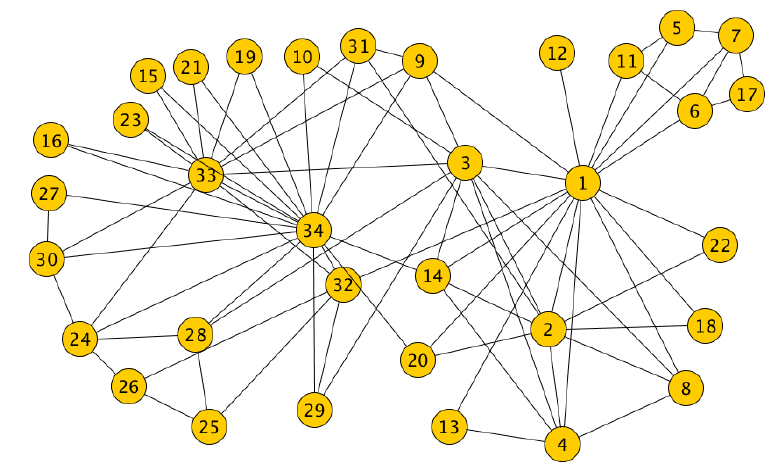
Figure 5. The Zackary Karate club network graph. Table 2. Results for the karate